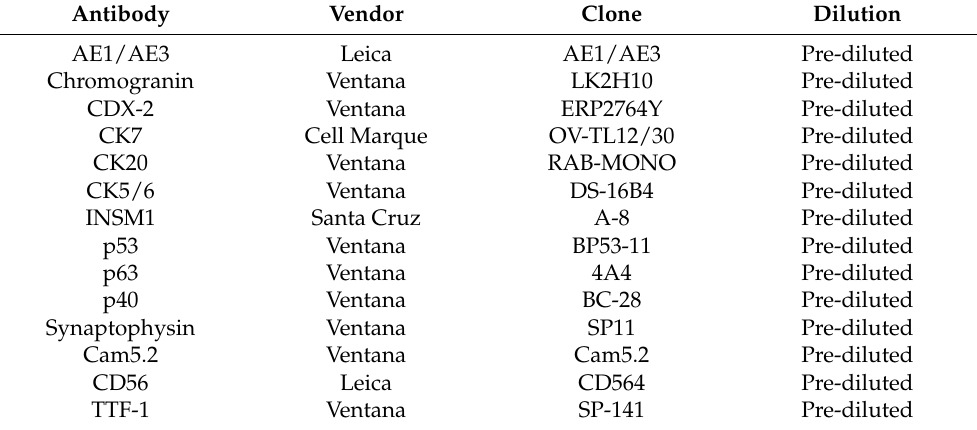
Table 1. Primary